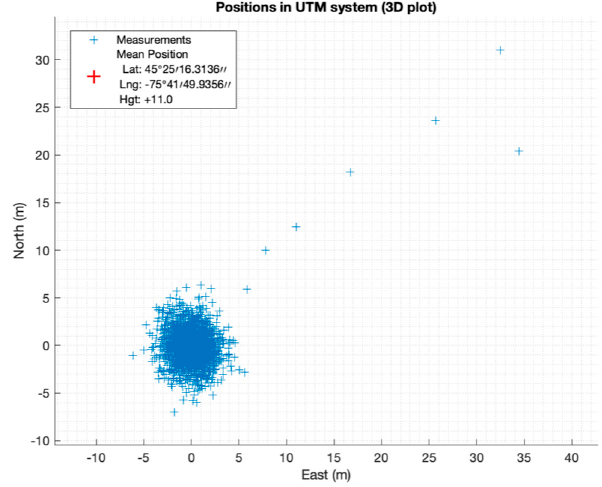
Figure 16. East, north, and up position errors.